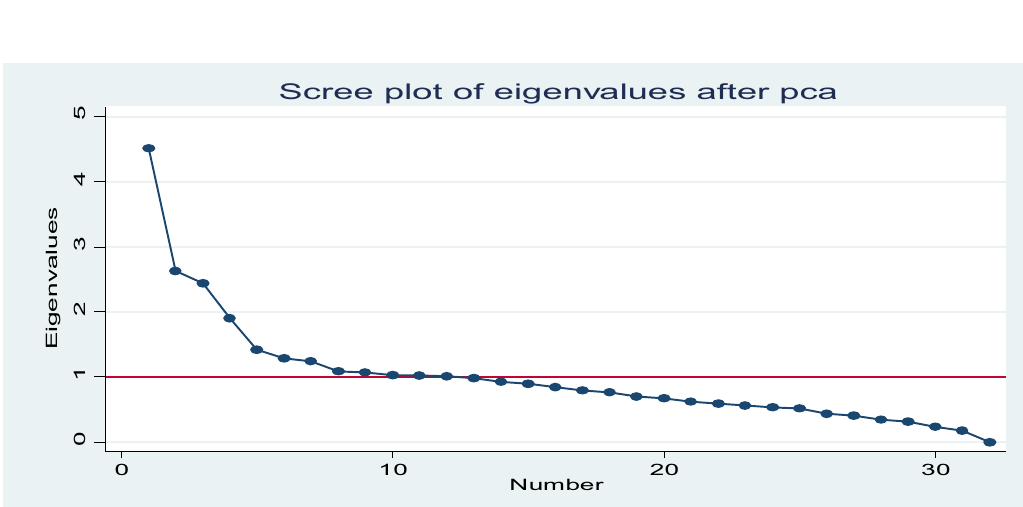
Table 3. Analytical hierarchy process (AHP) which shows priority matrix.